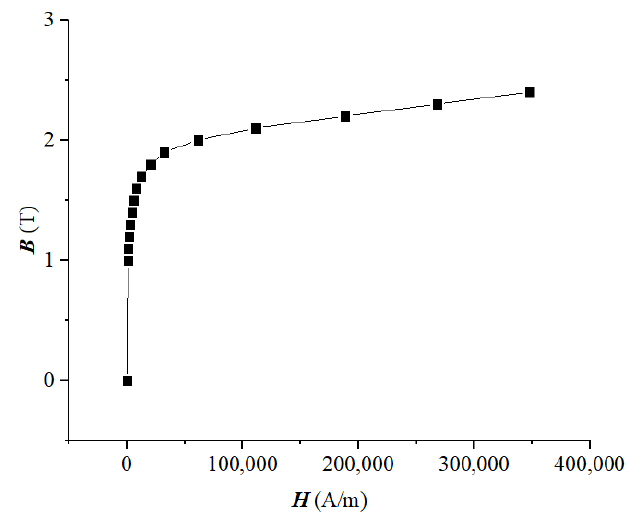
Figure 3. The B - H curve for nonlinear material.